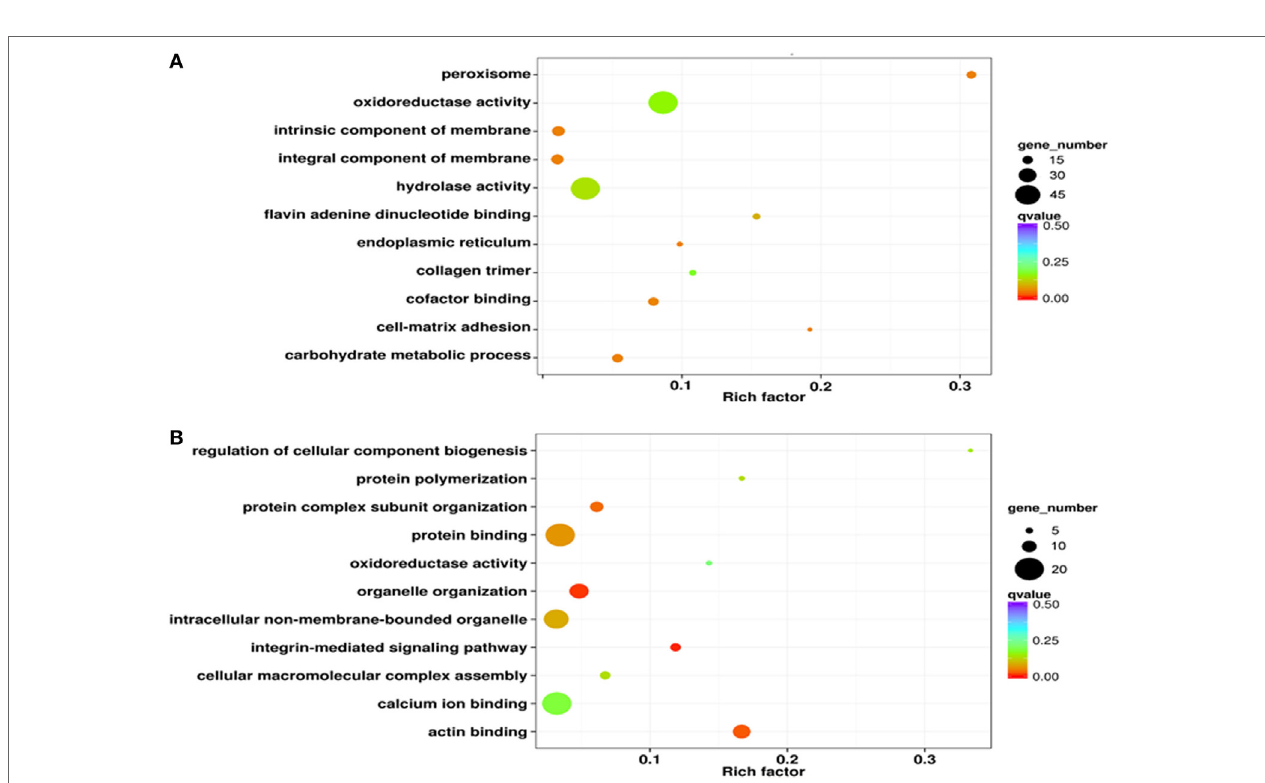
FigUre 4 | Gene ontology enrichment analysis of differentially expressed proteins from iTRAQ. The results of this enrichment analysis are presented as scatterplots of high (a) and low expressed (B) phagocyte differentially expressed proteins (DEPs). The enrichment factor in this case is the ratio of the DEP number to the number of all proteins in a certain enrichment term; the dot size in this figure denotes the number of DEPs, while colors correspond to the q value